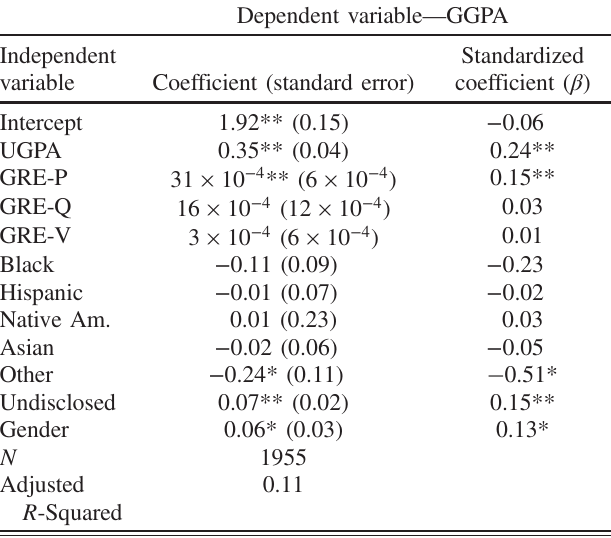
TABLE III. Coefficients of a multiple regression analysis modeling graduate GPA as a function of common quantitative admissions metrics. Reference categories are White for race and male for